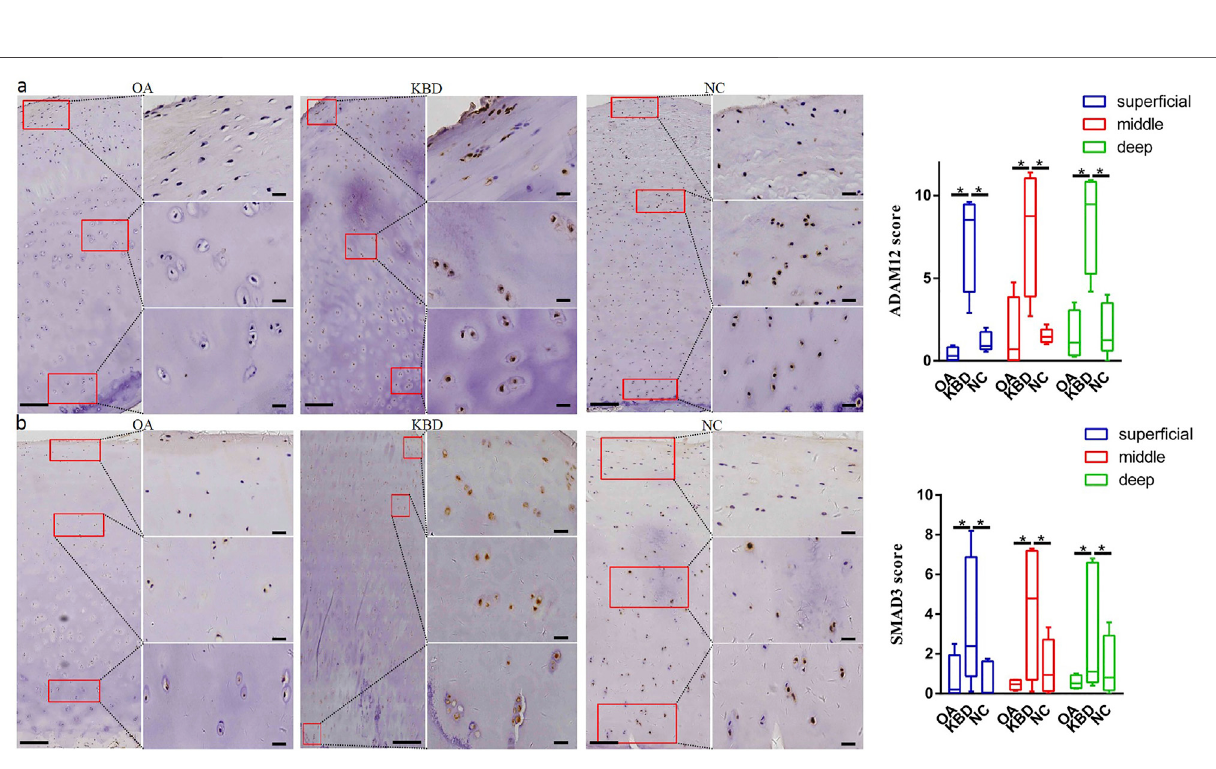
Frontiers in Genetics |